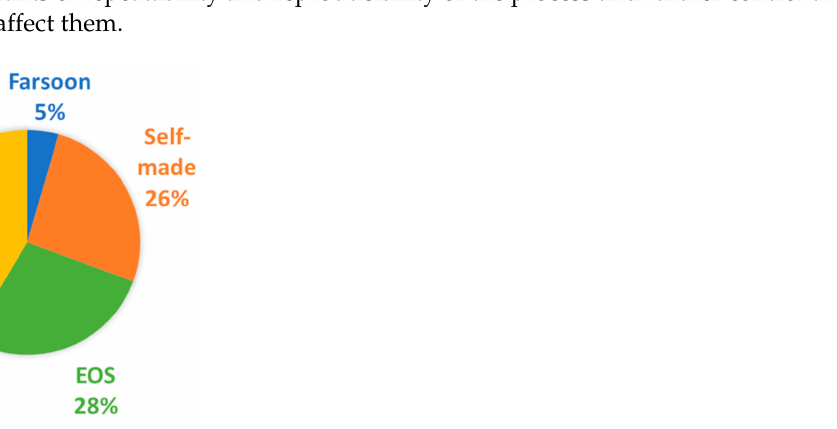
Figure 8. Share of L-PBF machine manufacturers reported for L-PBF of polymer powder feedstocks in the studies [11–111].